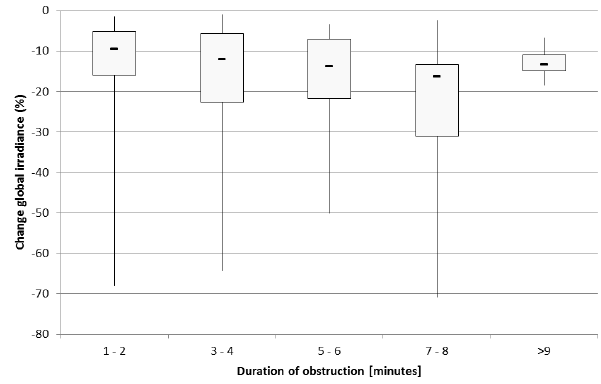
Figure 5. Box and whisker plots of the change in global irradiance as a function of the duration of the sun obstruction by contrails. The high-low lines show minimum and maximum values. The box shows the 25 and 75 quartile and the dash shows the median. Be- cause of a low number of cases at larger durations of obstruction the change in global irradiance is shown as a function of 2min intervals instead of 1min